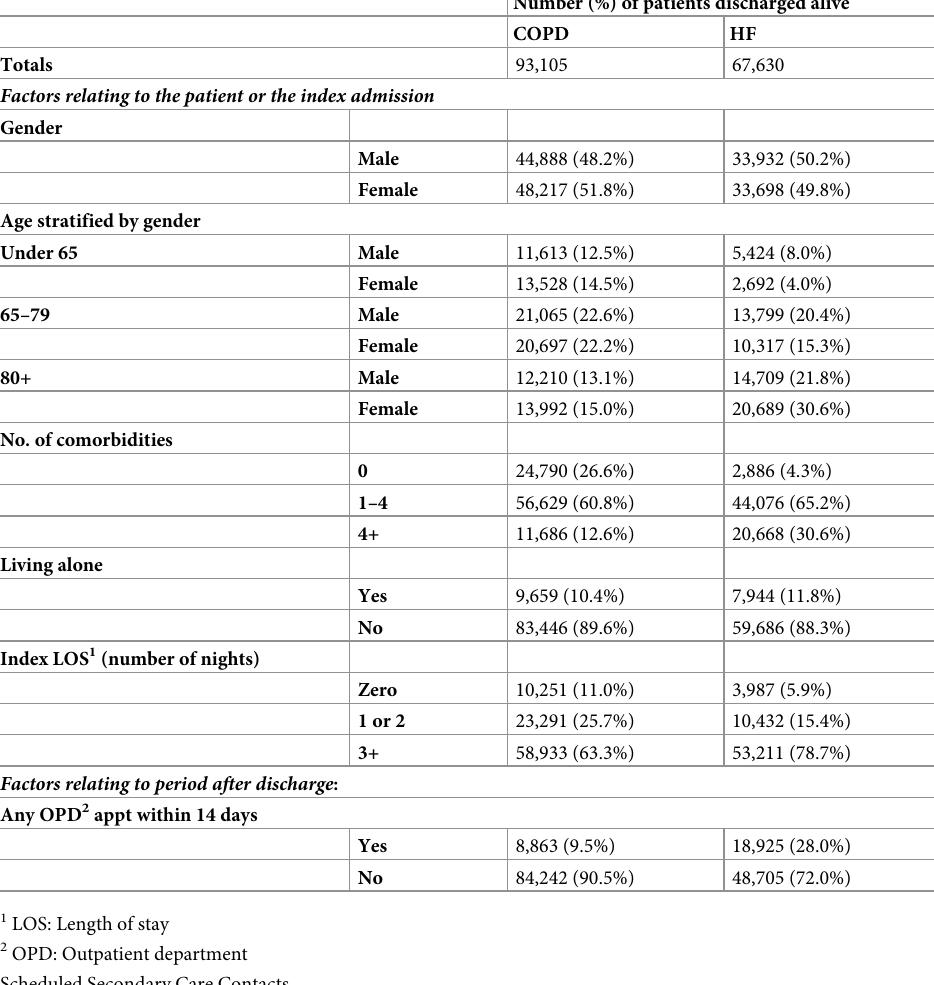
Table 1. Summary of discharged patients and the proportion of each group making emergency contact with sec- ondary care or being admitted within 30